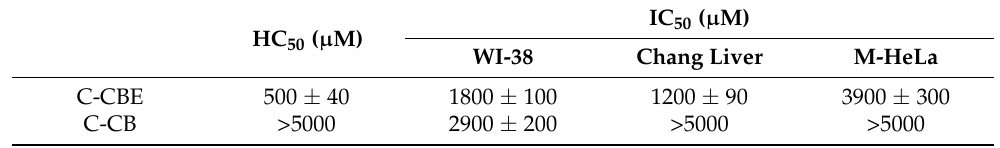
Table 1. Hemolytic activity and cytotoxicity of compounds C-CBE and C-CB.